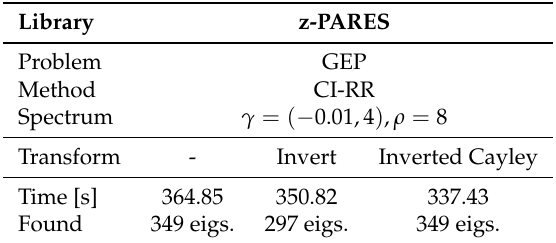
Table 14. ENTSO-E: impact of spectral transforms of the CI-RR